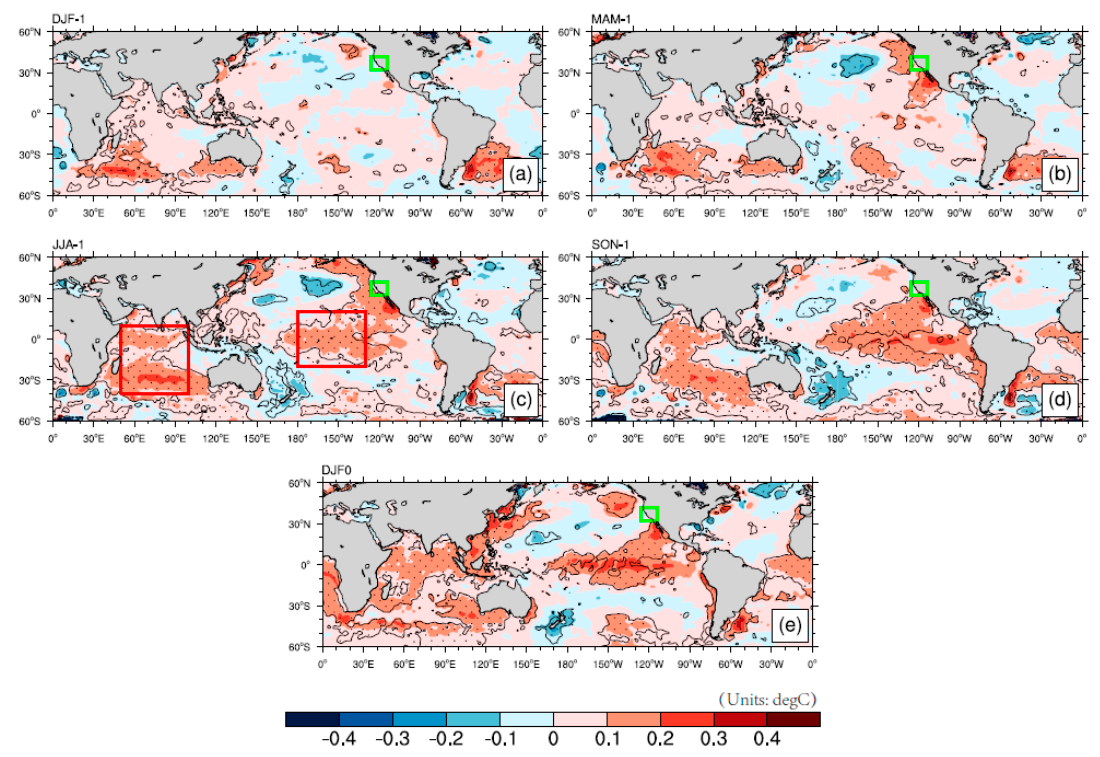
Figure 9. Same as in Figure 3, except for PC2.